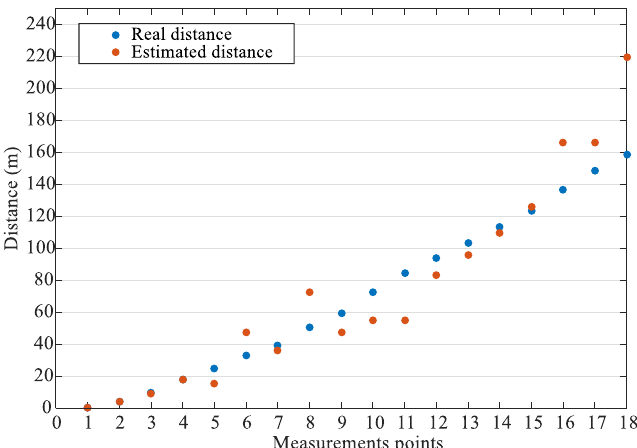
Figure 21. Communication Drivers Distance Measurement and Estimation.